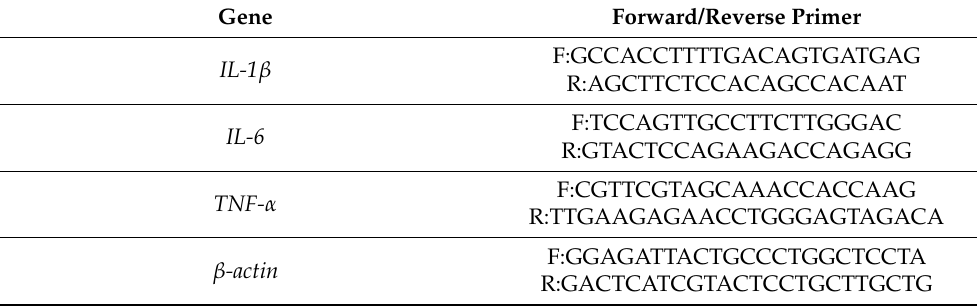
Table 1. Primer sequences for qRT-PCR in